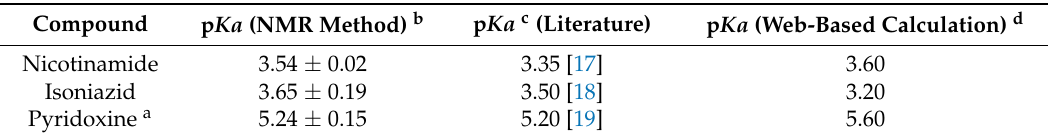
Table 1. The determined p Ka values by NMR experiments, literature data, and predicted values based on computational approaches.